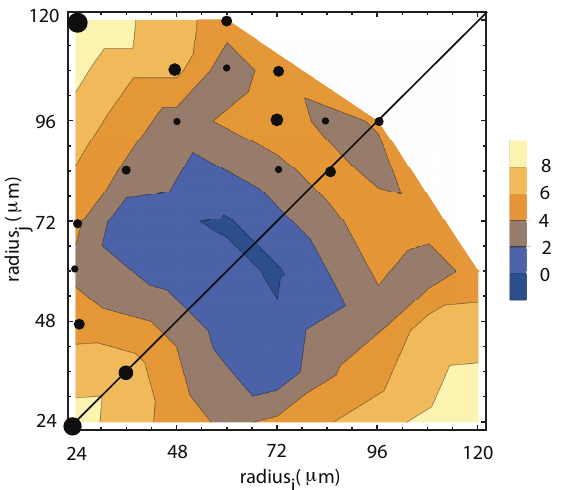
Figure 6. A logarithmic contour plot of the positive transition rates for WHOV images show solid circles proportional to the relative power law exponent (see the color legend). The logarithmic contour plot shows two dominant mechanisms for generating droplets: (1) small droplets that collide with droplets of any radius; and (2) preferential coalescences of large droplets with similar